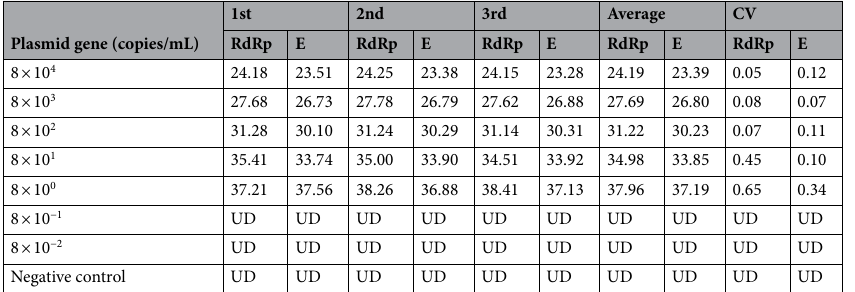
Table 4. Sensitivity and repeatability of RT-qPCR amplification of SARS-CoV-2 plasmid cloned RdRp and E genes. 1st, 2nd, and 3rd refer to three independent analyses of each plasmid sample; CV, coefficient of variation; UD,